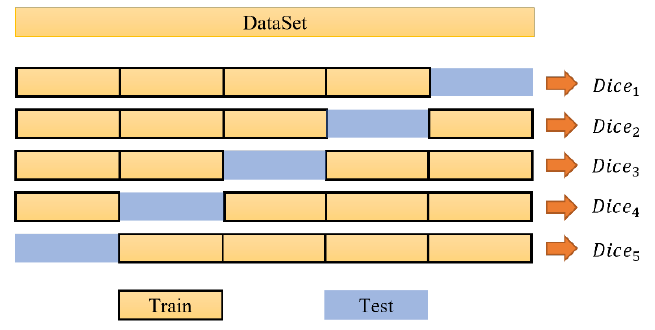
Figure 7. Data splitting process of five-fold cross-validation.